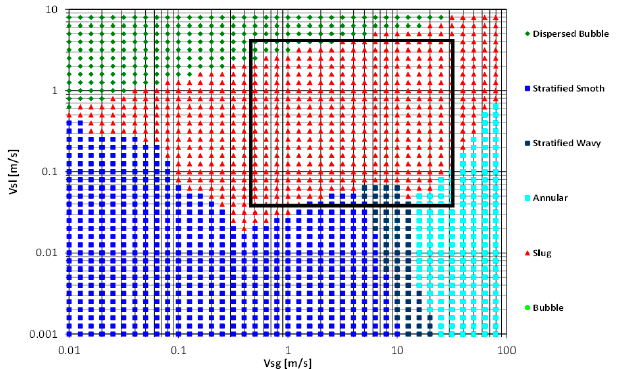
Figure 15. Air-water (without DRP) flow pattern map using Unified [17] Model in a 1.01-cm pipe. (Dashed box is the present work flow conditions) Where: DB: dispersed bubble, SL: Slug, IN: Intermittent, SS: Smooth Stratified, SW: Stratified Wavy, AN: Annular. The mixture friction factor f (cid:2897) and the mixture Reynolds number Re (cid:2897) for the two-